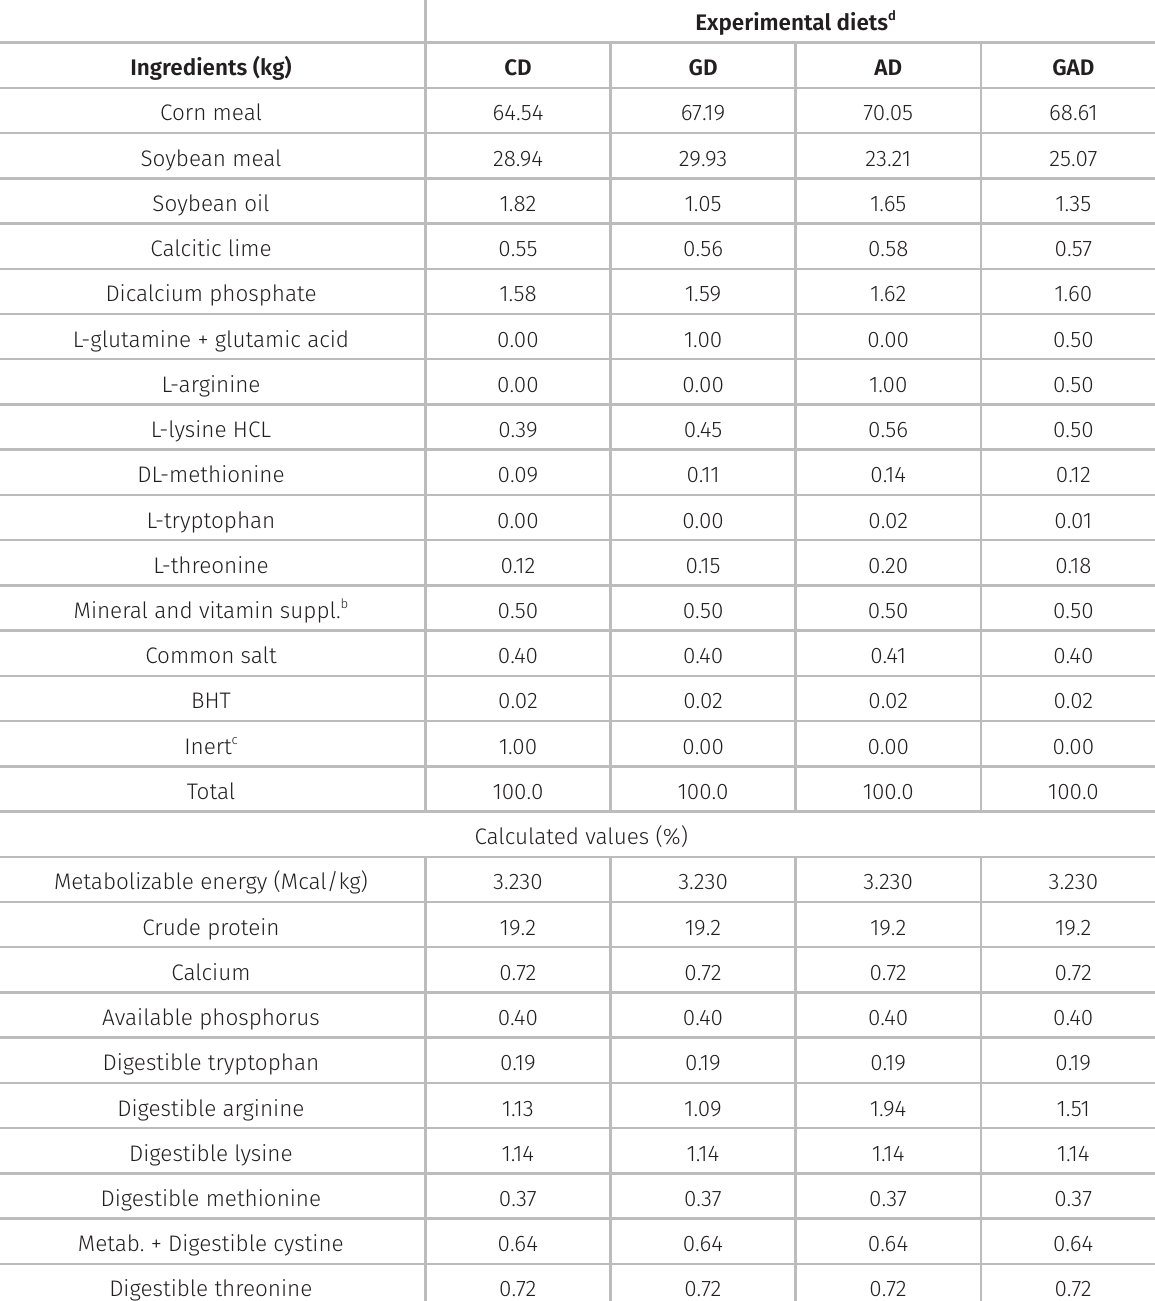
Table III. Formulation and chemical composition of experimental diets used for piglets weighing 15-30 kg a .